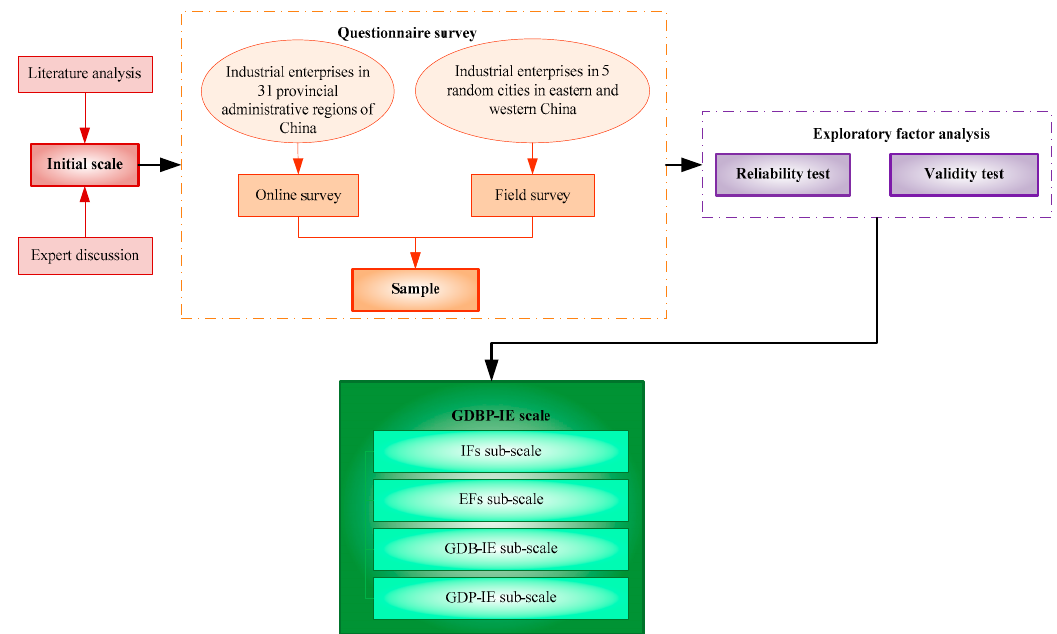
Figure 1. Framework for GDBP-IE scale development. Note: IFs—internal factors; EFs—external factors; GDB-IE—green development behavior of industrial enterprises; GDP-IE—green